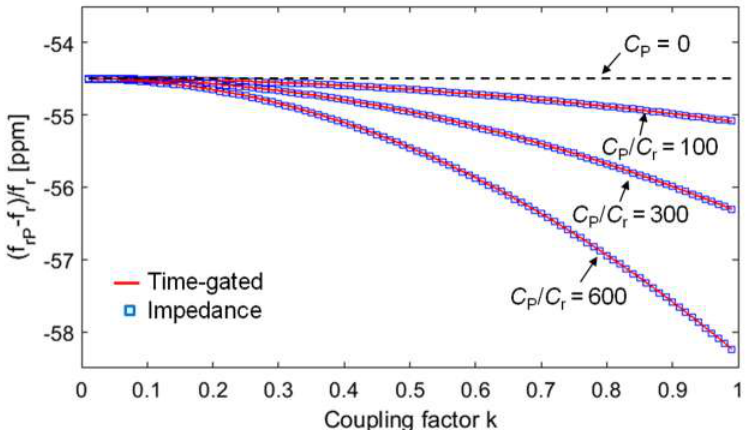
Figure 13. Comparison of the relative deviation ( f rP − f r )/ f r obtained from the time-gated technique and the impedance technique as a function of k for three different values of the ratio C P /C r .